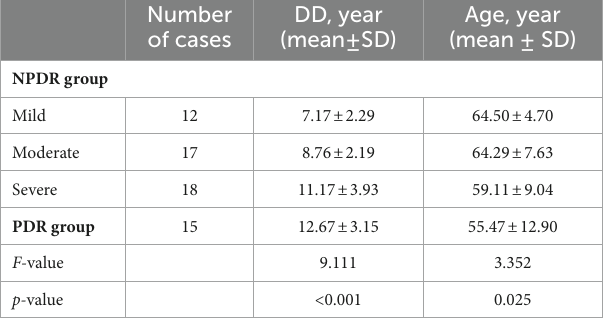
TABLE 2 Comparison of the basic data of each subgroup of DR